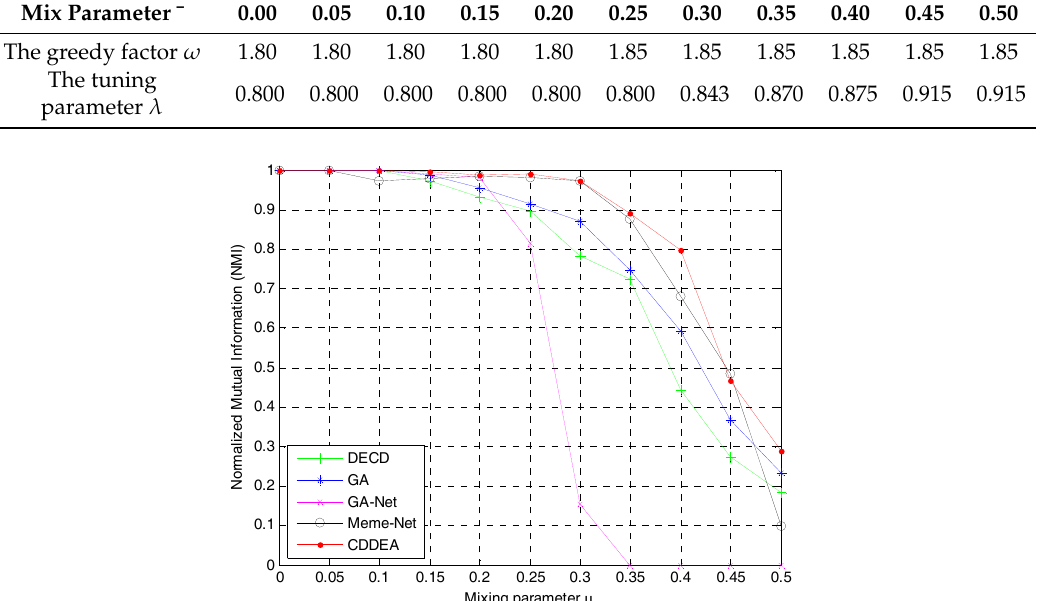
Table 7. Setting parameters in CDDEA for different networks.